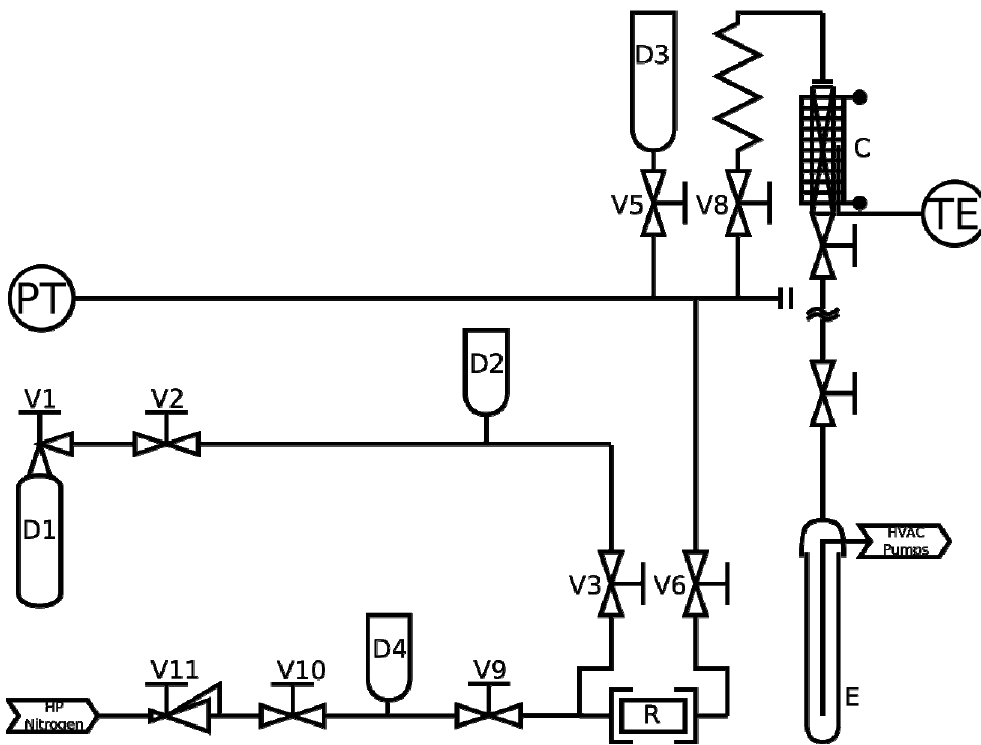
Figure 2. Schematic of the etching apparatus. D1: Hydrofluoridric acid cylinder; D2,D3,D4: Expansion drums; V1-V11: valves; R: Etching reactor; C: Heated soda lime trap; E: Cold trap; PT: Pressure transducer; TE: